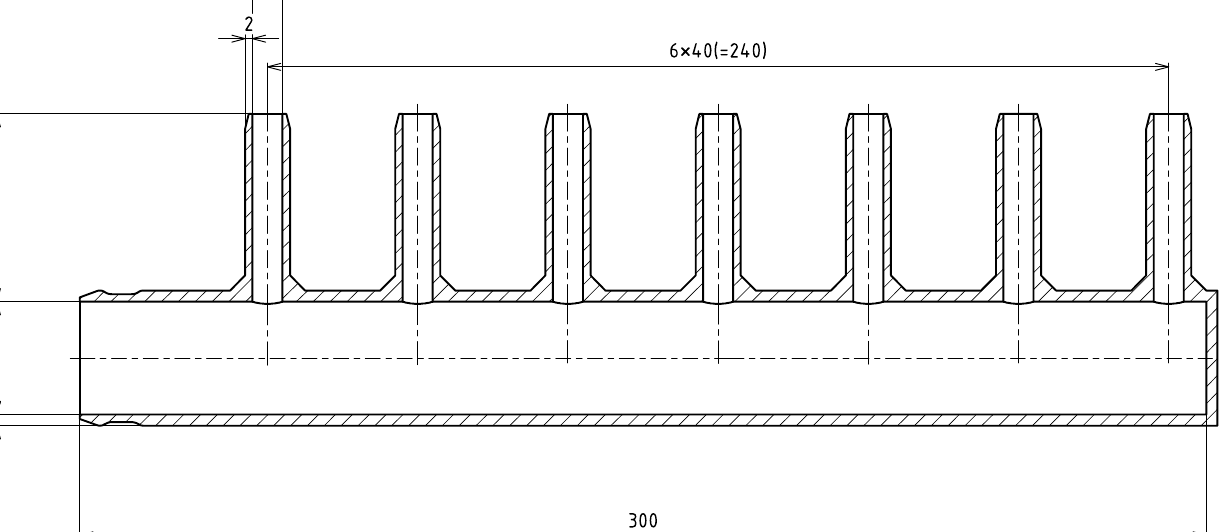
Figure 2. Schematic of the distributor n07.